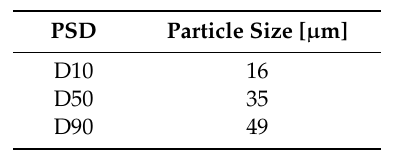
Table 2. Particle size distribution (PSD) of the